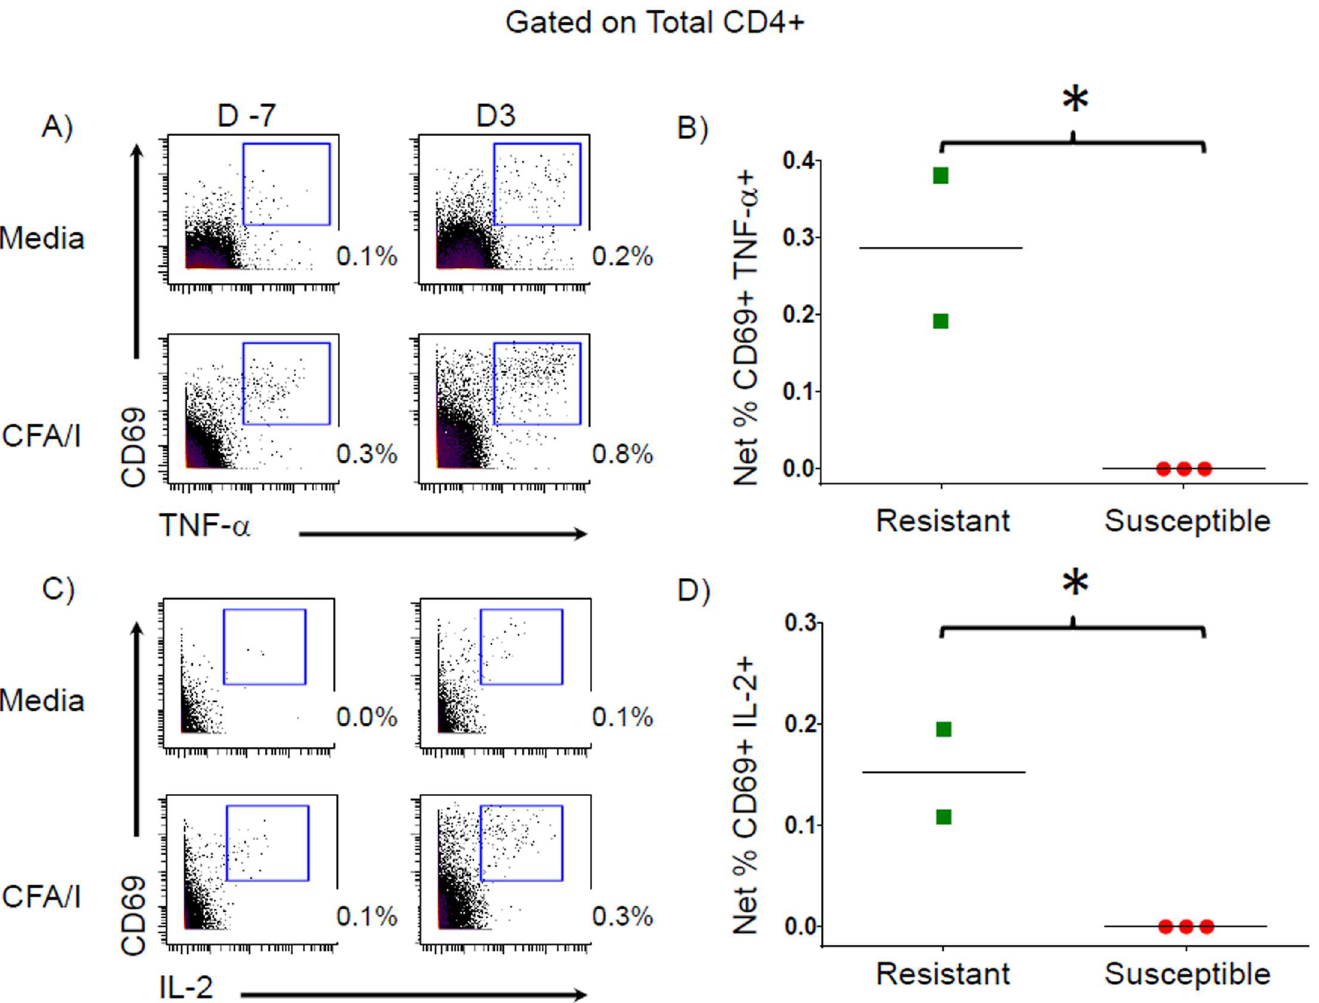
Fig 1. Cytokine production by total CD4+ T cells. A & C) Representative histograms, from a Resistant volunteer, demonstrating TNF- α (A) and IL-2 (C) productionby total CD4+ T cells followingstimulationwith CFA/I in the presenceof Golgi inhibitors. B & D) Net TNF- α (B) and IL-2 (D) production(CFA/I stimulatedminus media), D3 –pre-vaccination, by total CD4+ T cells in Resistant (green squares) and Susceptible (red circles) volunteers. * p <